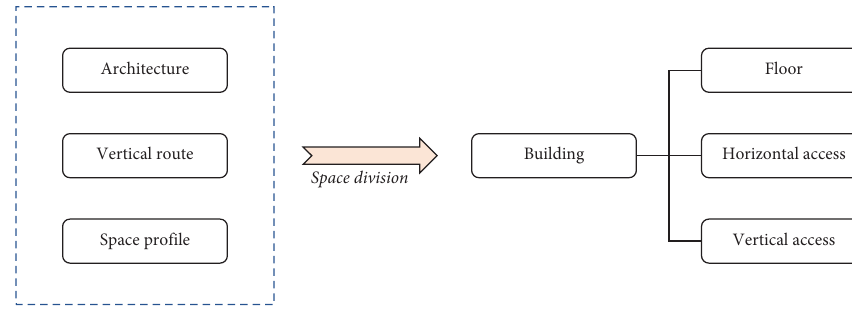
Figure 6: Interior space of the building.